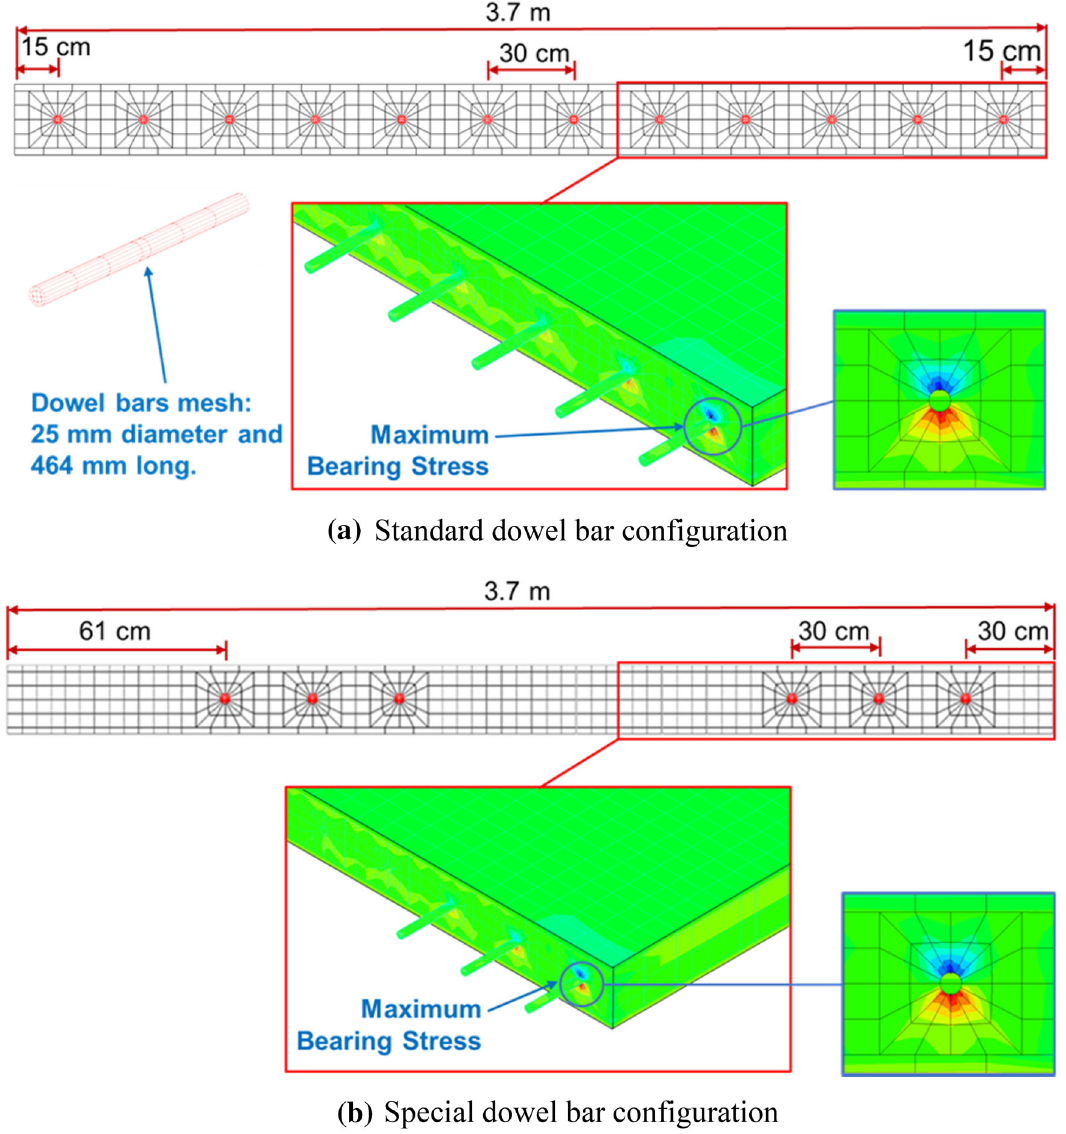
Fig. 10 Slab and dowel bar mesh and bearing stress contour